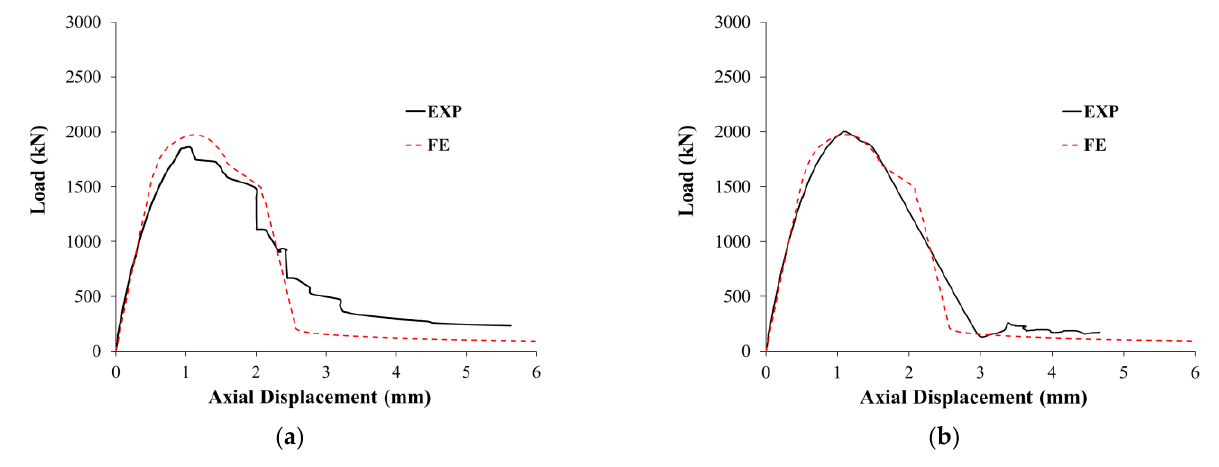
Figure 19. Experimental versus FE load-displacement curves for: ( a ) control specimen CW1; ( b ) con- trol specimen CW2.